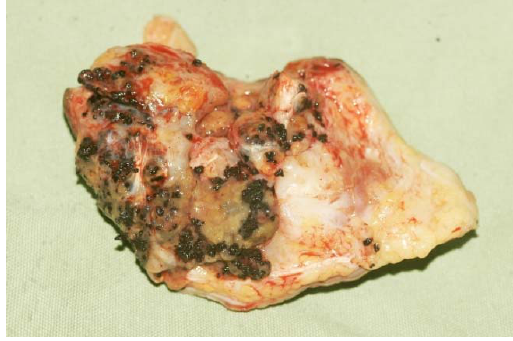
Figure 3. Surgical specimen with multiple black grains.